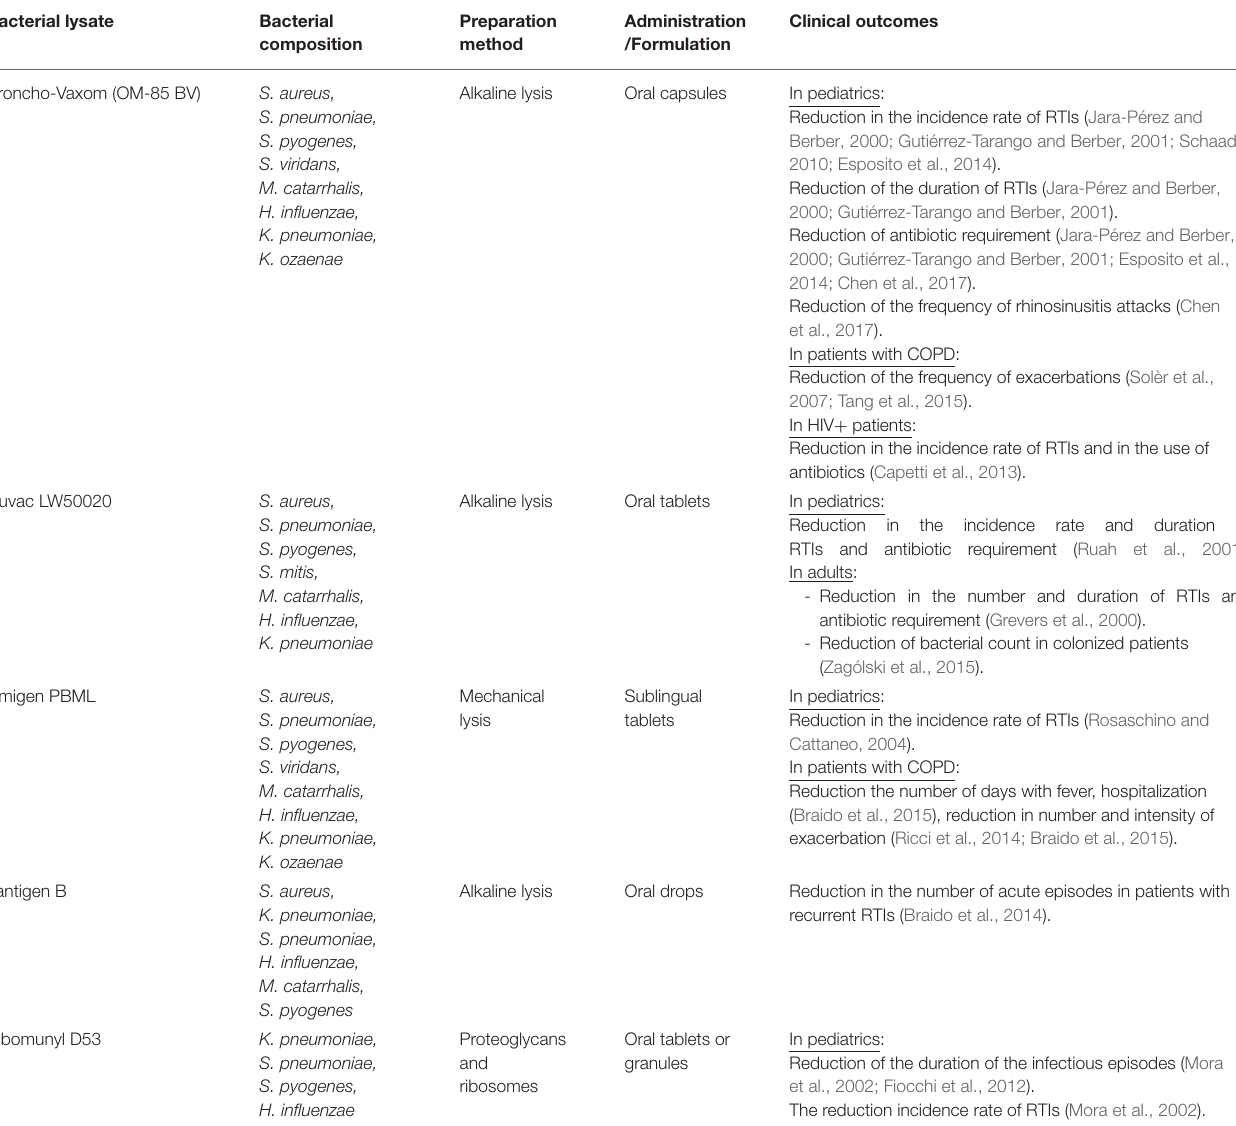
TABLE 1 | Characteristics and clinical outcomes of commercial bacterial lysates used for treating RTIs. Bacterial